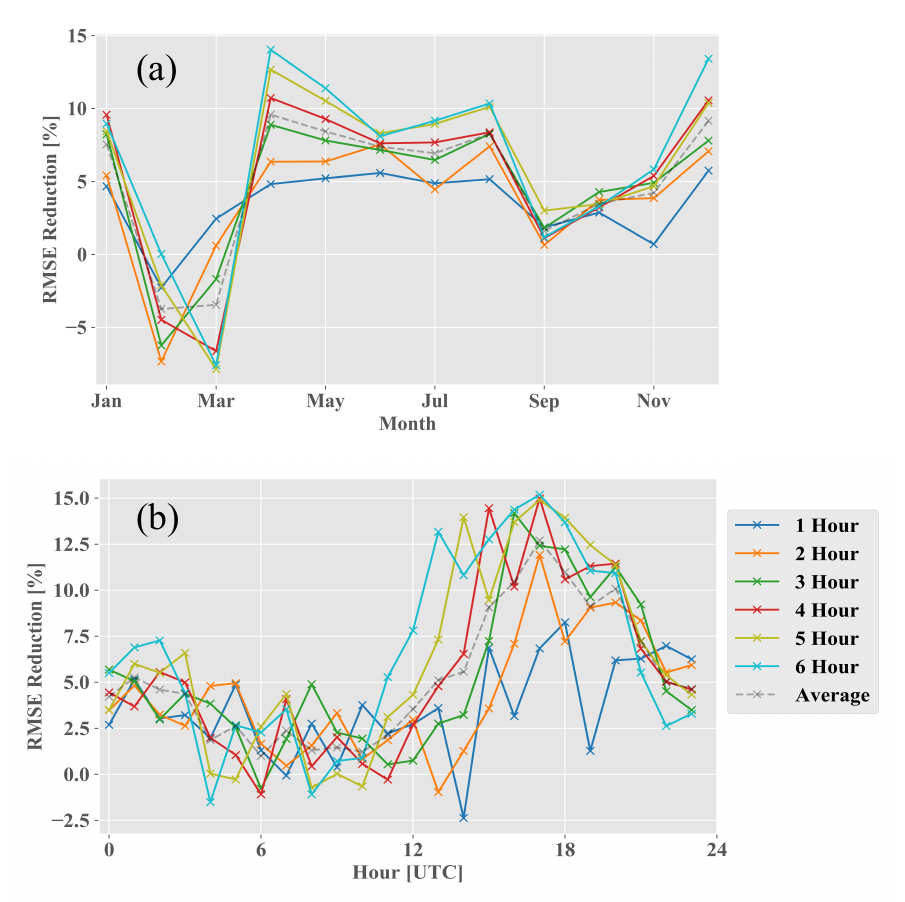
Figure 5. Reduction in RMSE obtained by the DE model at FINO1 as partitioned by ( a ) month and ( b ) hour of the day (local time = UTC + 0100 h). Solid lines represent forecasts one to six hours in advance, while the dashed line represents the average over all